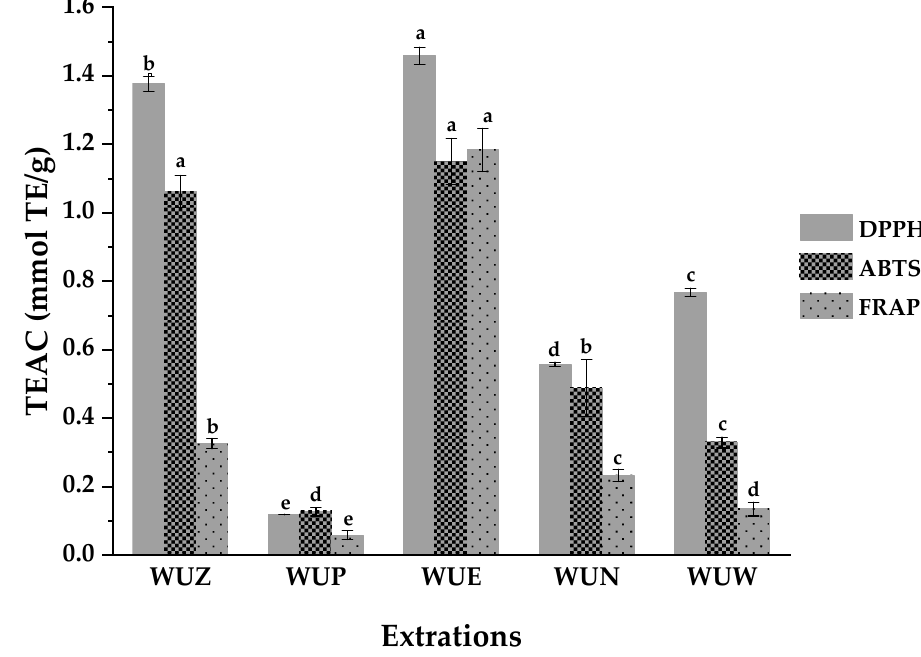
Figure 1. Trolox equivalent antioxidant capacity (TEAC) of different extracts from stem barks of W. ugandensis tested by DPPH, ABTS, and FRAP assays. Means labeled by different letters (a–e) were significantly different at a level of p < 0.05 (n = 3) by DMRT (Duncan’s multiple range test).